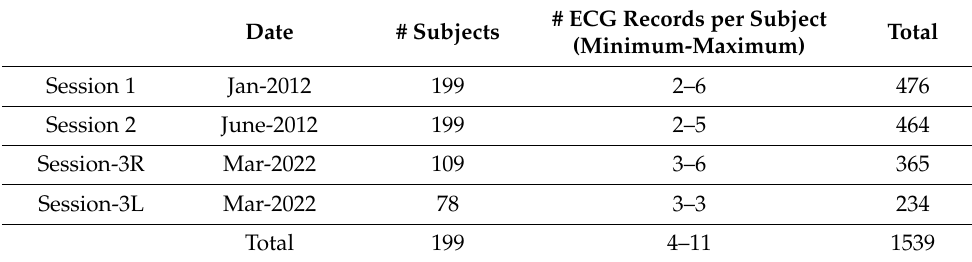
Figure 1. ECG data collection using the ReadMyHeart device. Table 2. Number of ECG records per session in the Heartprint dataset.